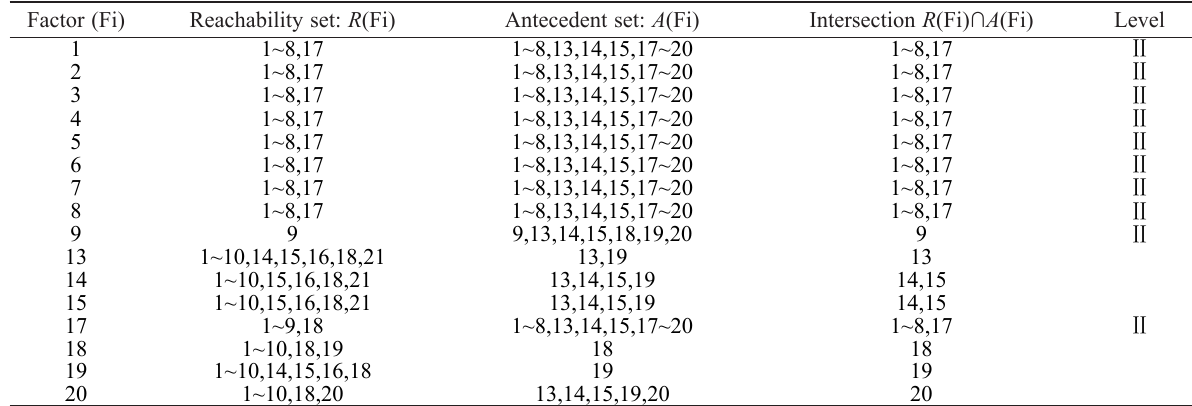
Table 7. Second iteration of Reachability